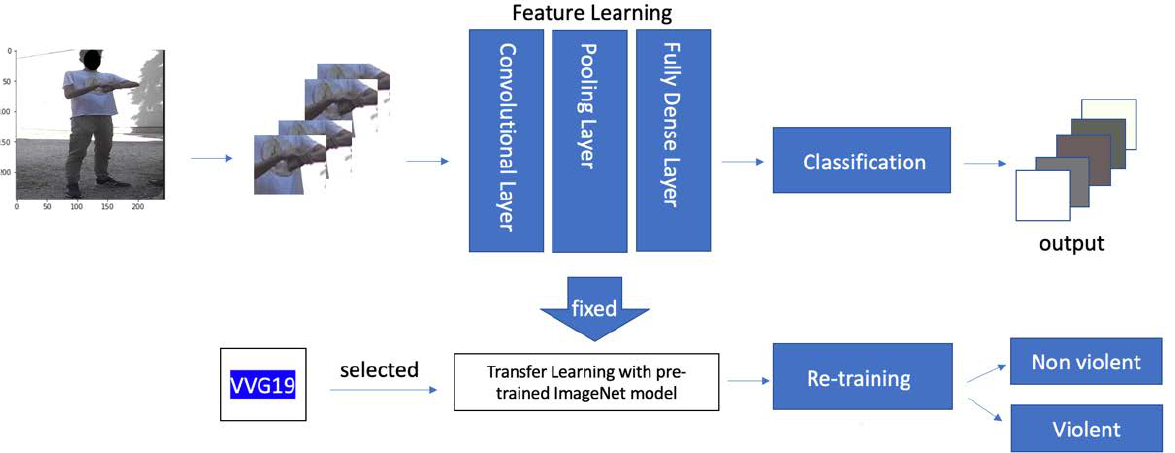
Figure 9. Logical architecture of the extended SVD enriched with transfer learning with pre-trained ImageNet model.